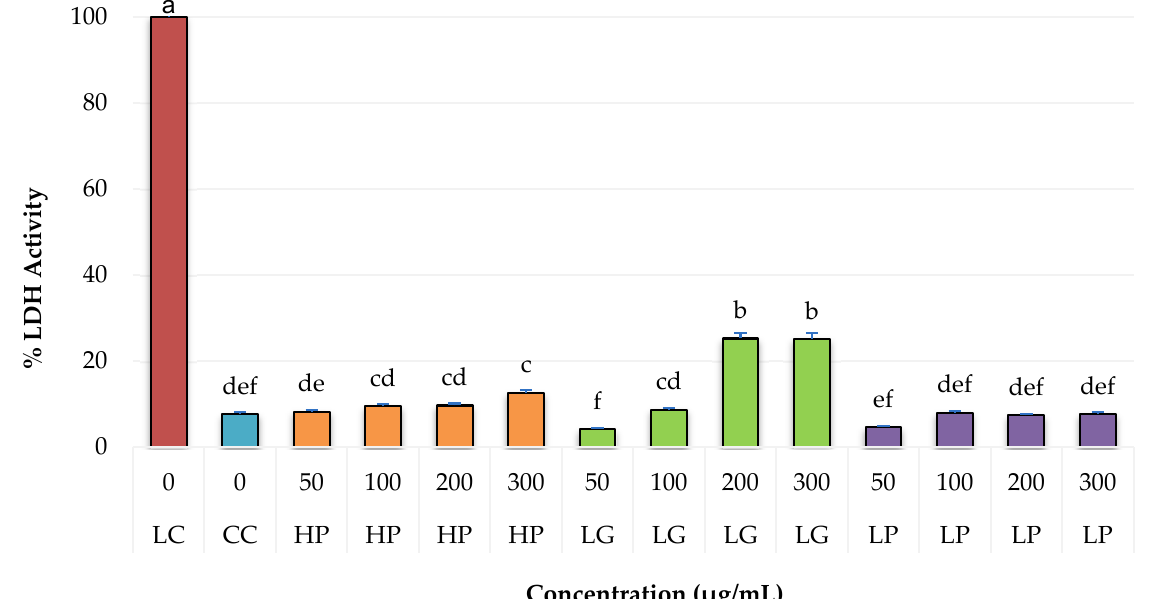
Figure 2. Cytotoxicity of PRE from L. graveolens (LG) on normal fibroblast cells (NIH3T3), expressed as a percentage of lactate dehydrogenase activity (LDH). LC (Lysis Control), CC (Cell Control). Values with a different letter are statistically different ( p ≤ 0.05). Results are expressed as means (n = 3) ± standard deviation (bars).